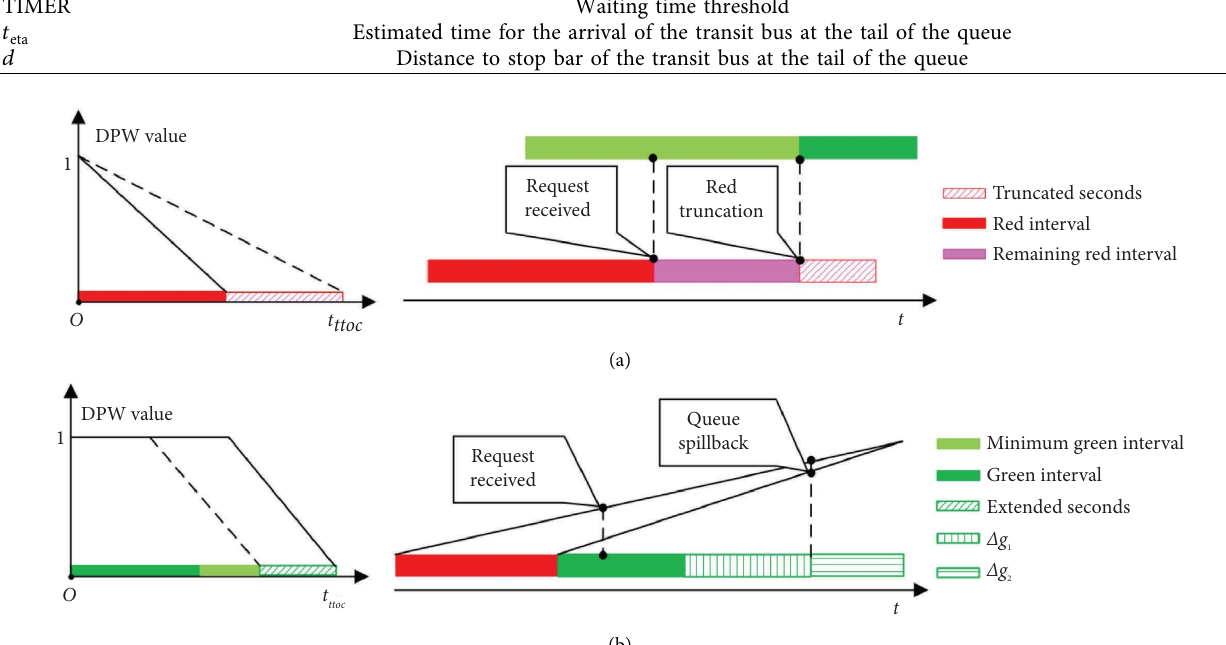
Figure 3: Te unifed DPW function curve for two cases of vehicle arrival during the efective green of the confict and the current phase. (a) Efective green of the confict phase. (b) Efective green of the current